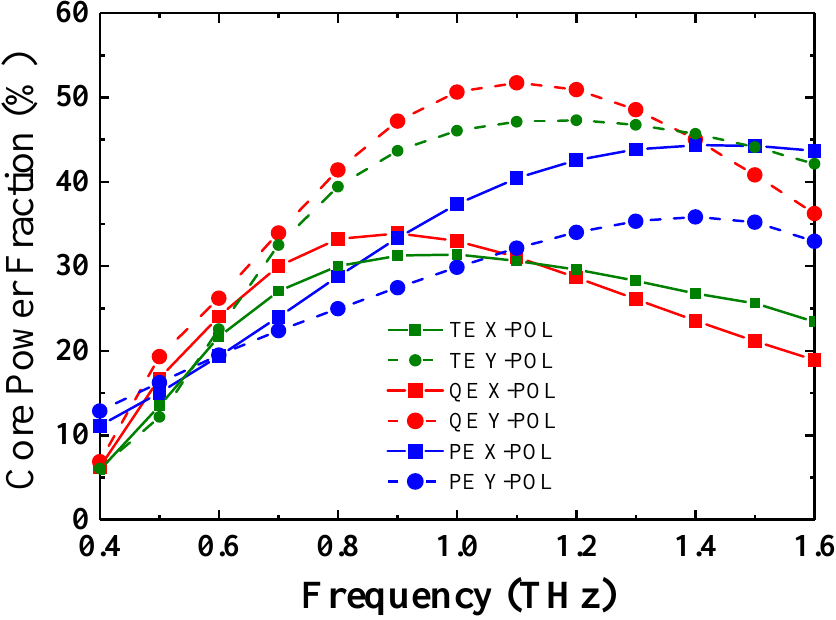
Figure 6. Fractional power flow in relation to frequency for the TE, QE, and PE designs.